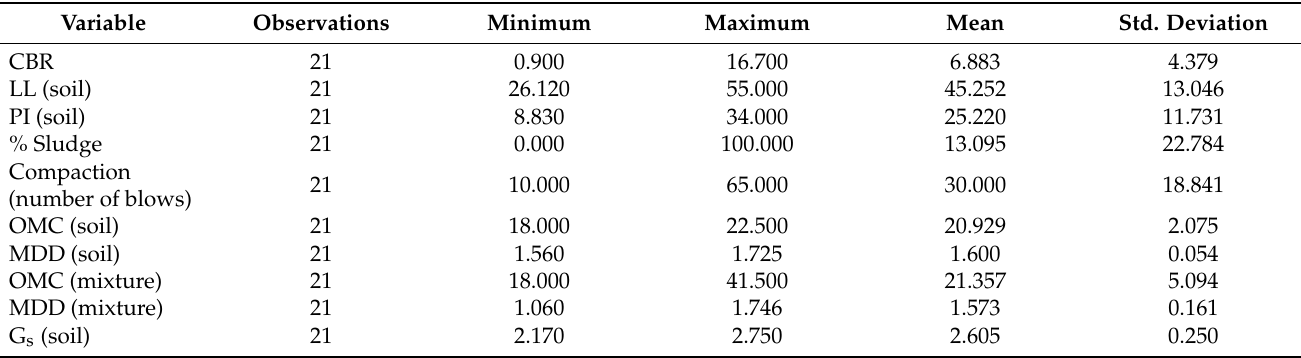
Table 2. The statistical information of the training database.